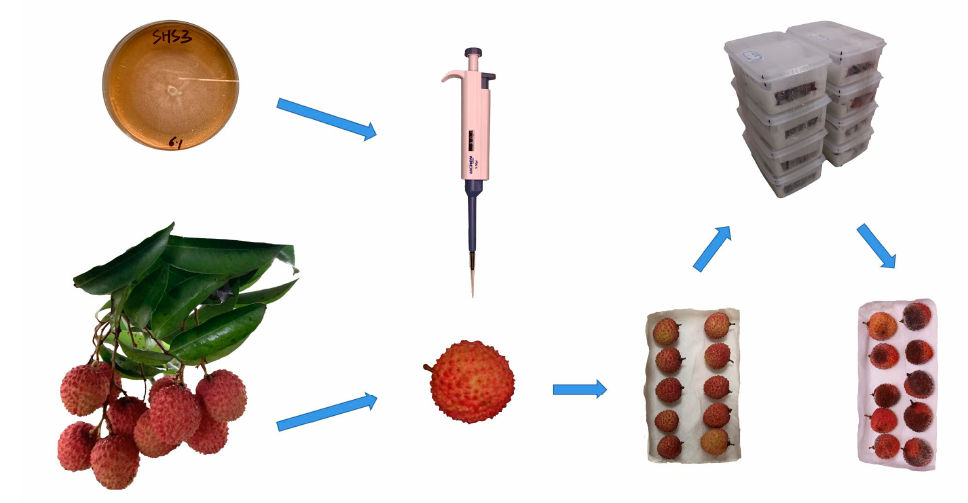
Figure 2. The process of the inoculation and cultivation experiment.